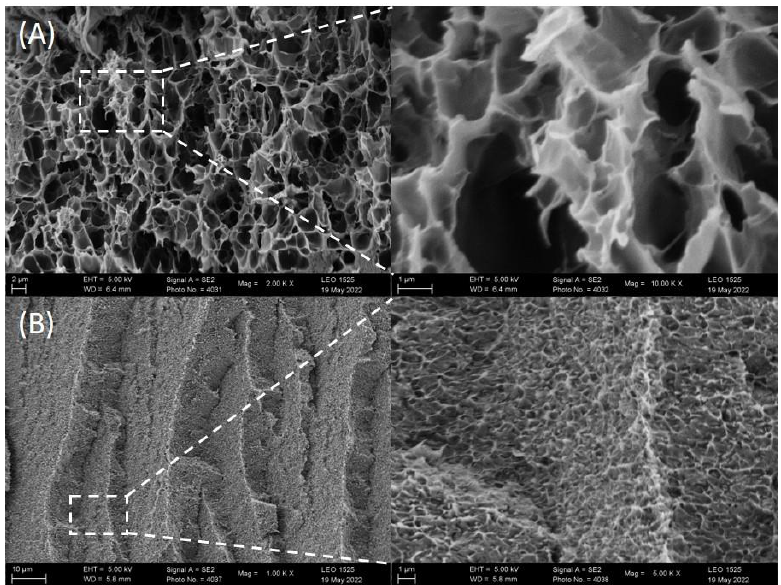
Figure 2. SEM images of the DN hydrogels with 10 wt% PVA before ( A ), and after ( B ) F-T operation.